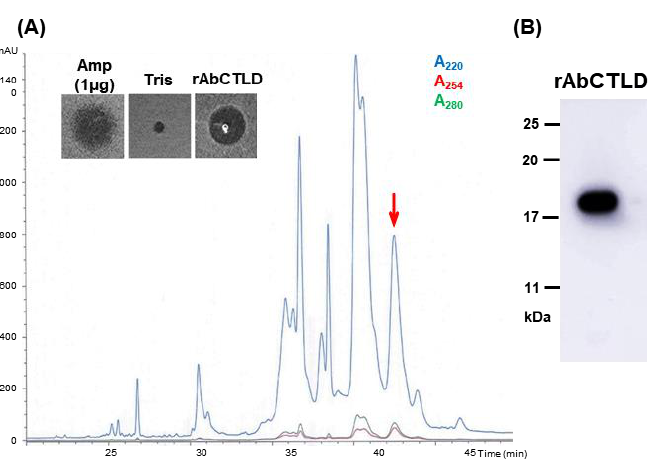
Figure 6. Purification of rAbCTLD using reversed-phase high-performance liquid chromatography (RP-HPLC). ( A ) Eluted fractions were evaluated using an ultraviolet light detector at 220 nm, 254 nm, and 280 nm. The fraction indicated by an arrow was lyophilized and dissolved in 100 mM Tris (pH 8.0). The antibacterial activity of this fraction against Bacillus subtilis is shown in the figure inset. ( B ) Immunoblotting analysis of purified rAbCTLD detected using anti-His 6 tag antibodies.